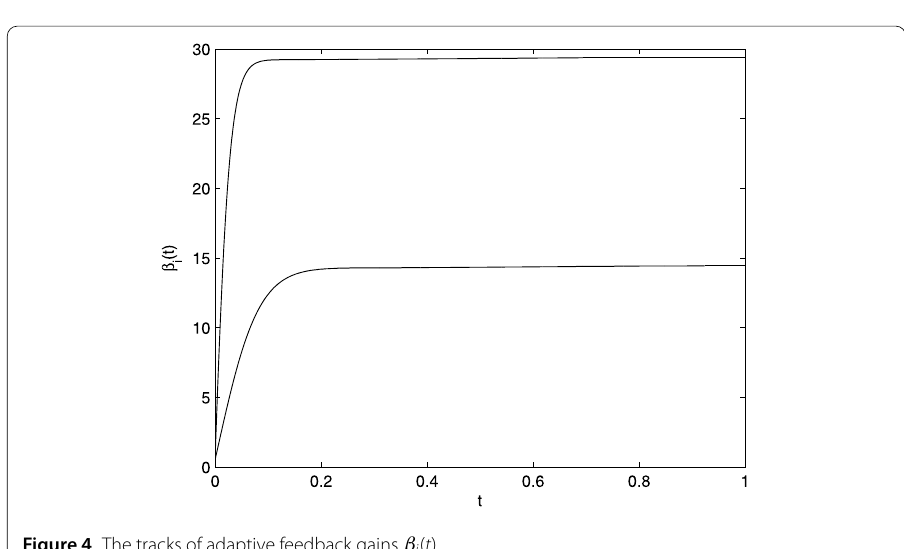
Figure 4 The tracks of adaptive feedback gains β i ( t )